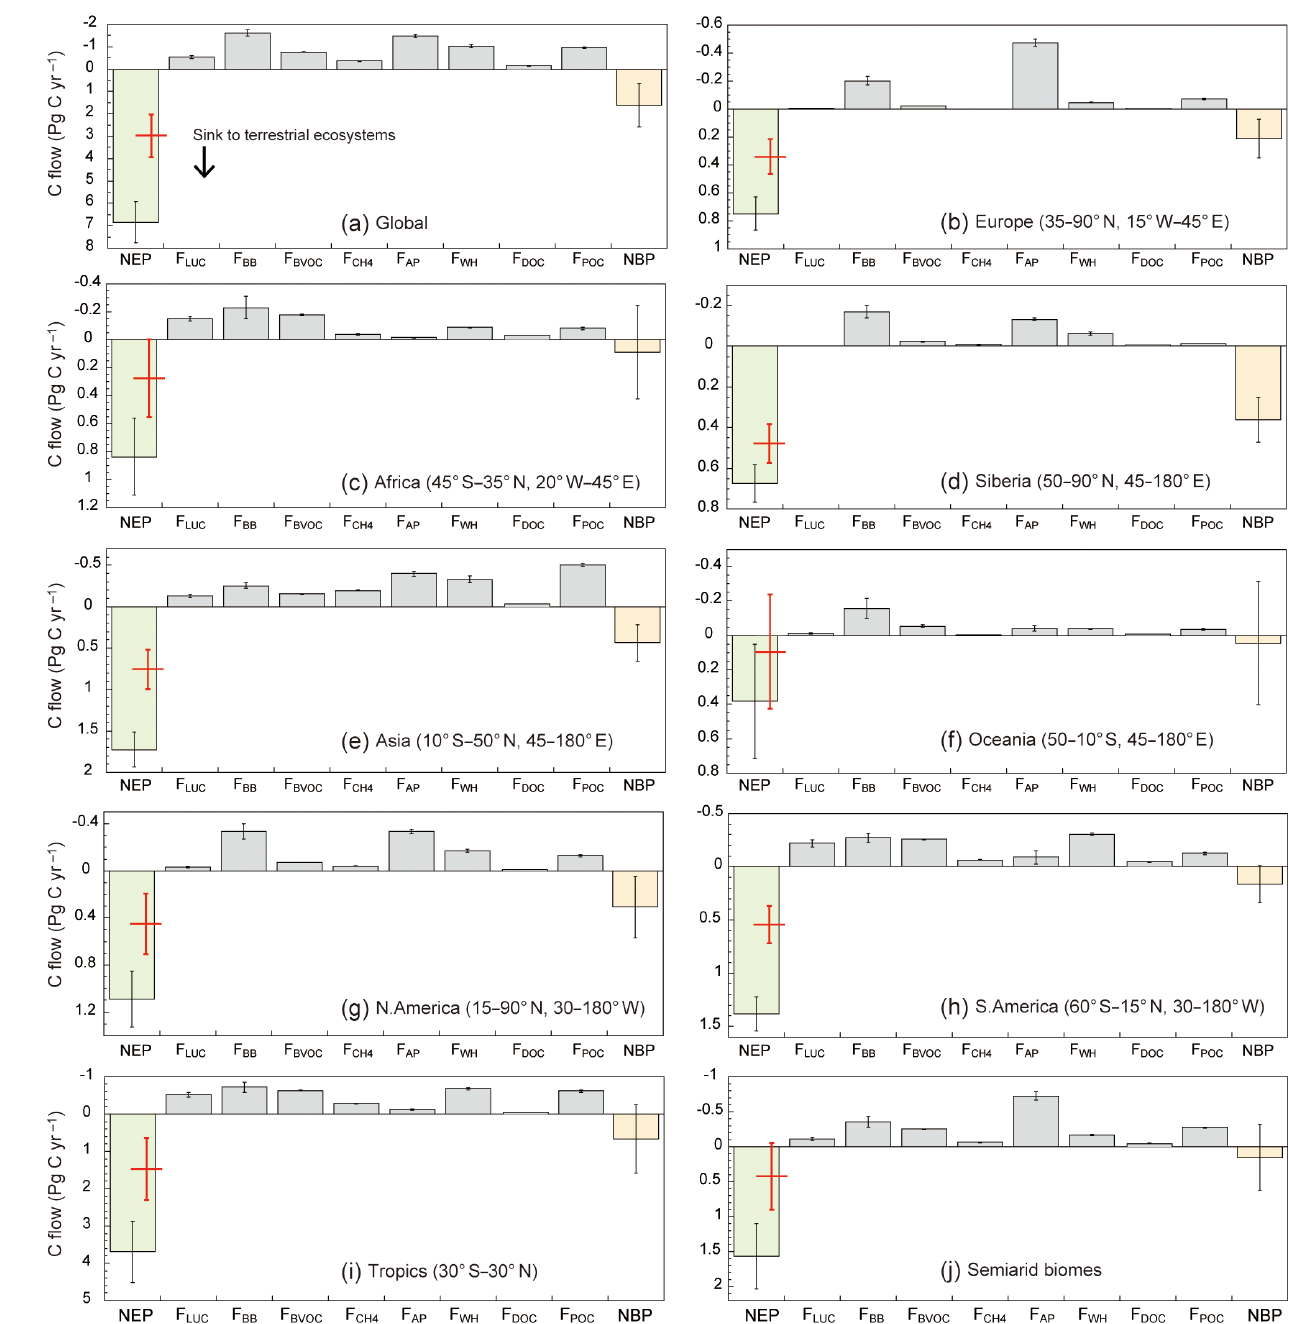
Figure 7. Regional portions of the terrestrial carbon budget in 2000–2009. Columns show the mean results of EX ALL and error bars show the standard deviation of interannual variability. Red lines show the mean and standard deviation of NEP in EX0. Note the differences in vertical